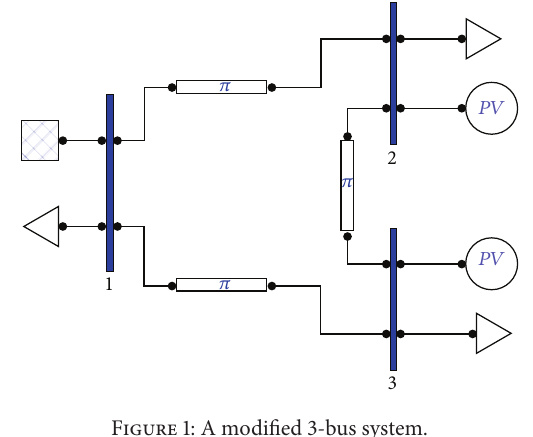
Figure 1: A modified 3-bus system.